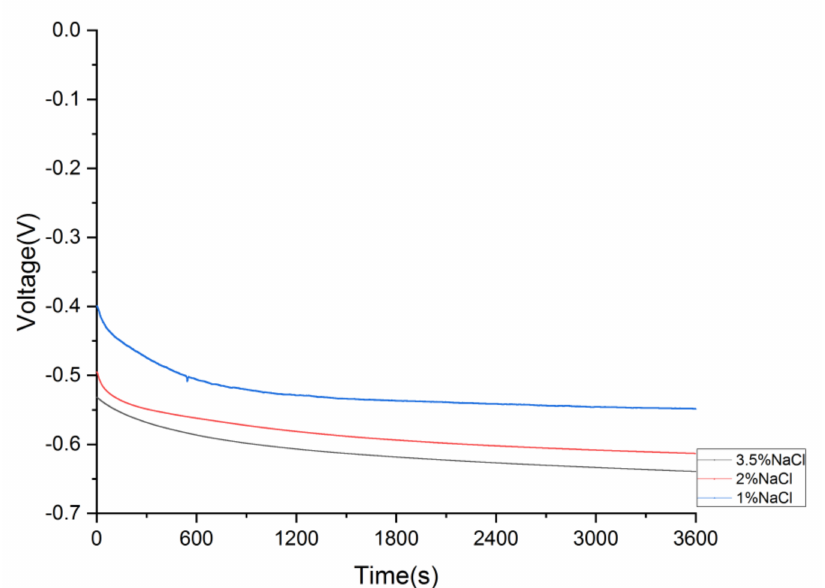
Figure 7. Potential is plotted against time for 1%, 2%, and 3.5% NaCl concentrations at 25 ◦ C when the flow velocity is kept at